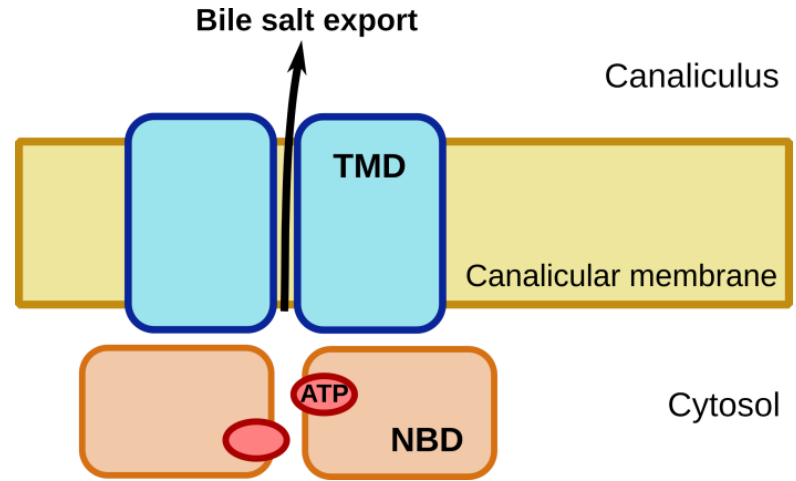
Figure 1. Schematic of the four-domain architecture of an ATP-binding cassette (ABC) transporter, as illustrated for the bile salt export pump BSEP. Hydrolysis of ATP by the nucleotide binding domains (NBD) energizes transport of bile salts from the hepatocyte cytoplasm to the bile canaliculus. Transmembrane domains (TMD) form the path for bile salt transport across the canalicular membrane.